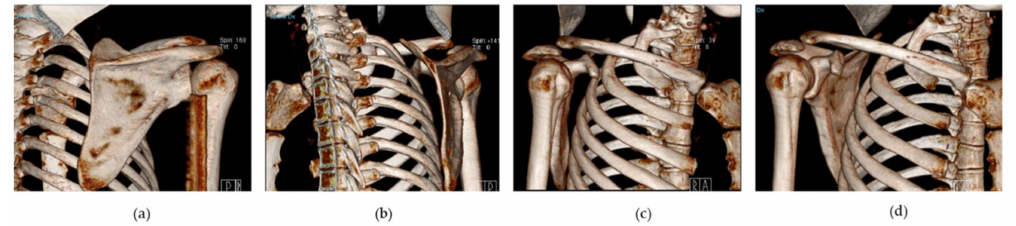
Figure 1. Representation of scapular posterior view ( a ), axillary view ( b ), lateral view ( c ), anterior view ( d